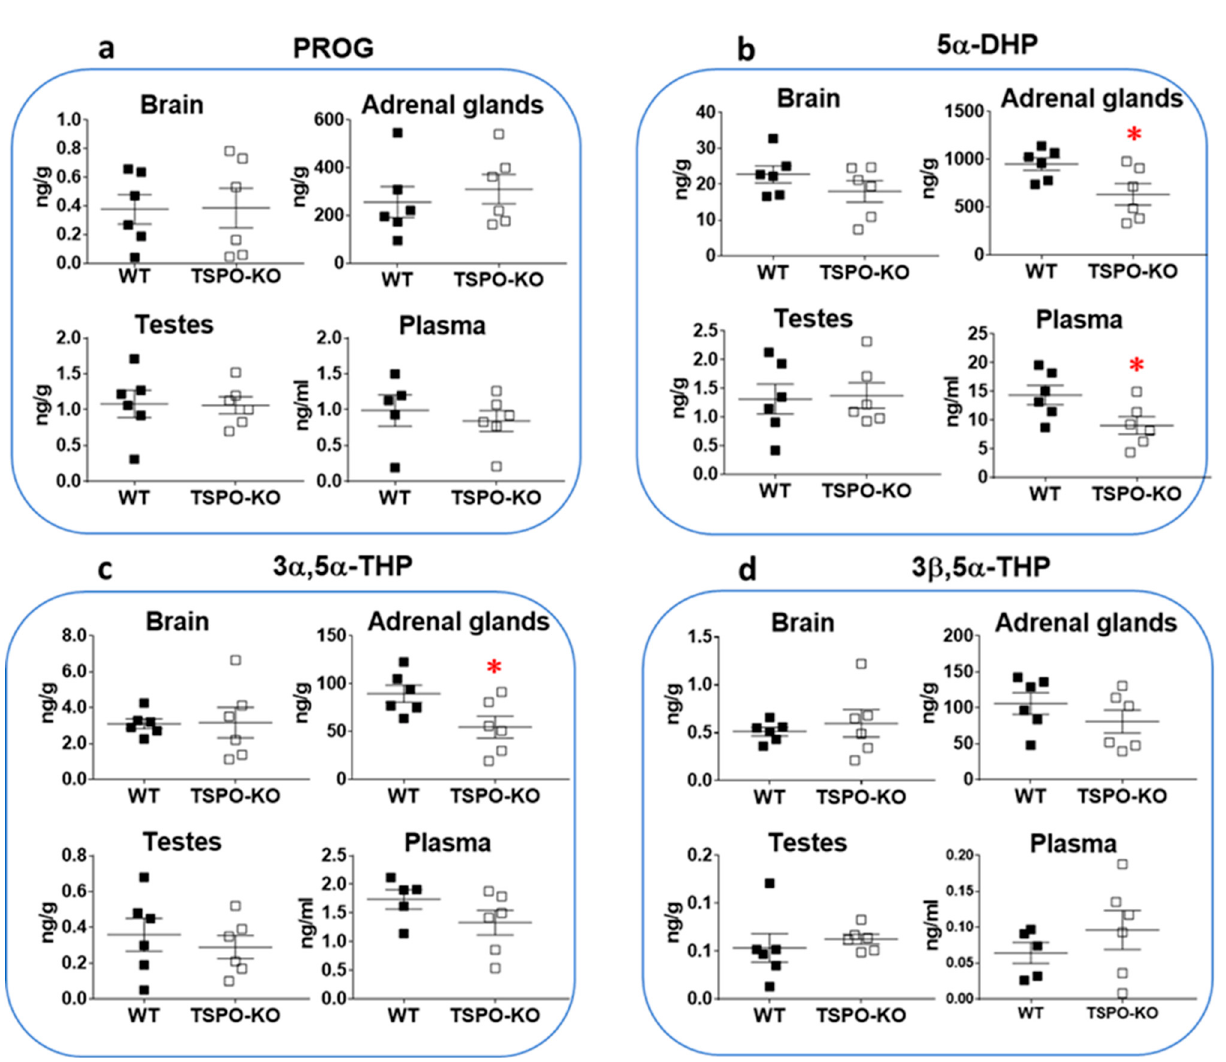
Figure 3. Concentrations of PROG, 5 α -DHP, 3 α ,5 α -THP and 3 β ,5 α -THP in tissues of male WT and TSPO-KO mice analyzed by GC-MS/MS as described in the Material and Methods section. Data are expressed as means ± SEM and were analyzed by unpaired t -test ( n = 5–6). * p < 0.05.